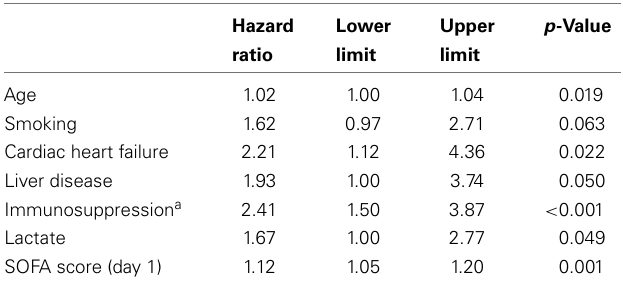
Table 4 | Risk factors for negative outcome in severe sepsis and septic shock*, multivariate stepwise cox regression analysis .